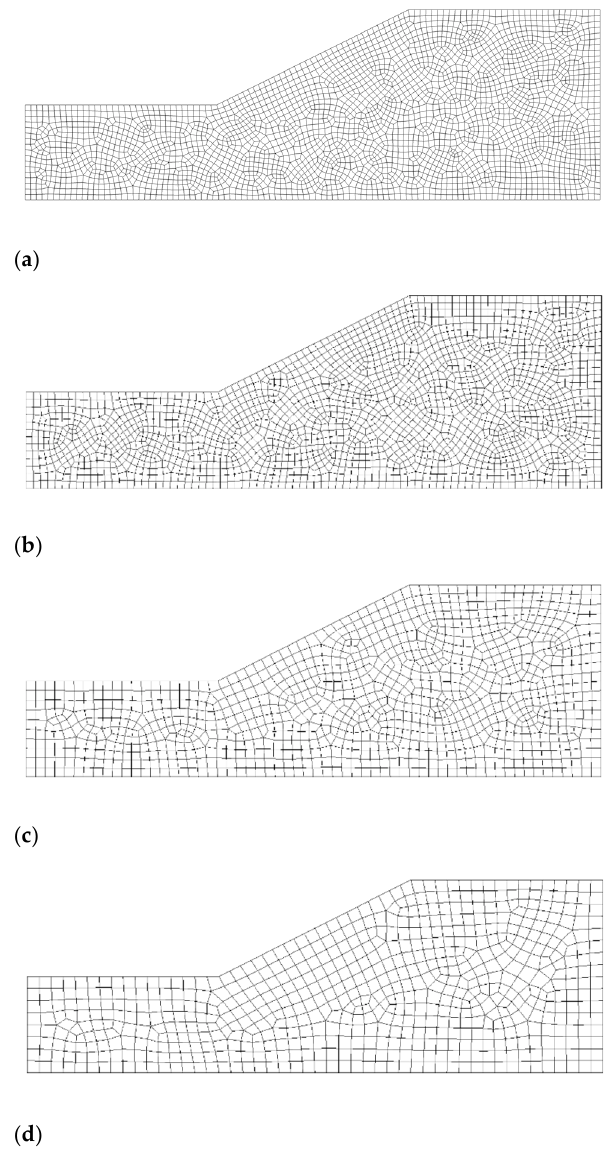
Figure 4. Four discrete models for the homogeneous slope. ( a ) Model A (2955 elements); ( b ) Model B (1977 elements); ( c ) Model C (1065 elements); ( d ) Model D (640 elements).